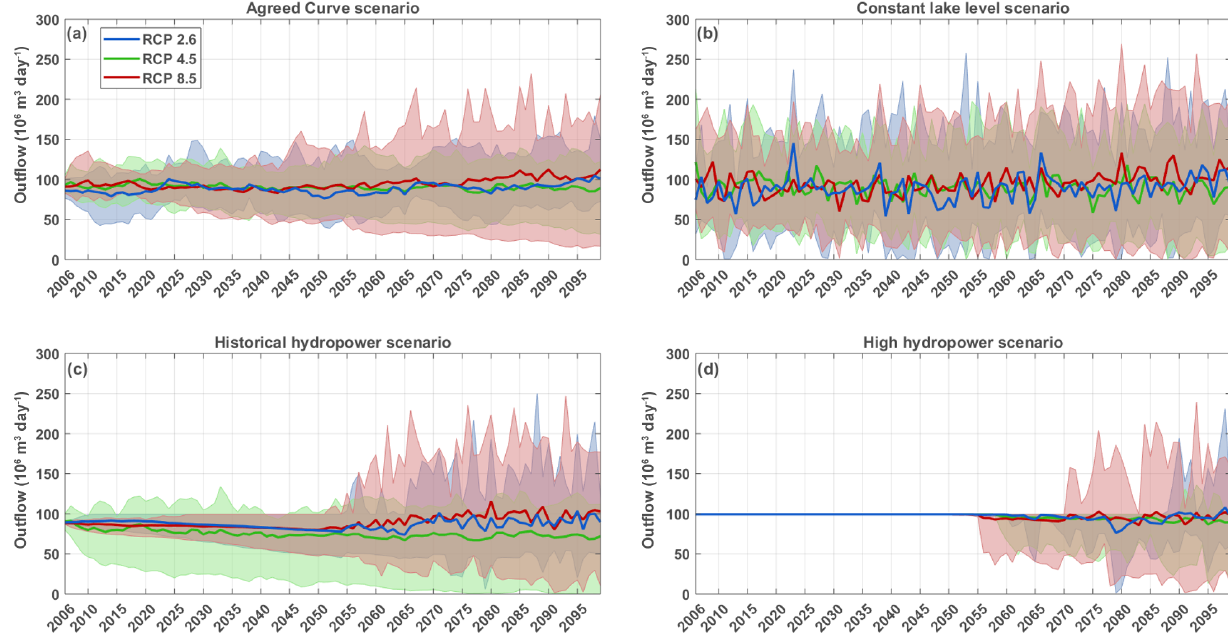
Figure 9. Outflow projections (annual averaged) for the Agreed Curve scenario (a) , the constant lake level scenario (b) , the historical HPP management scenario (c) and the high HPP management scenario (d) . The solid line shows the ensemble means and the envelope the 5th–95th percentiles of the CORDEX ensemble simulations, bias corrected using the parametric linear transformation